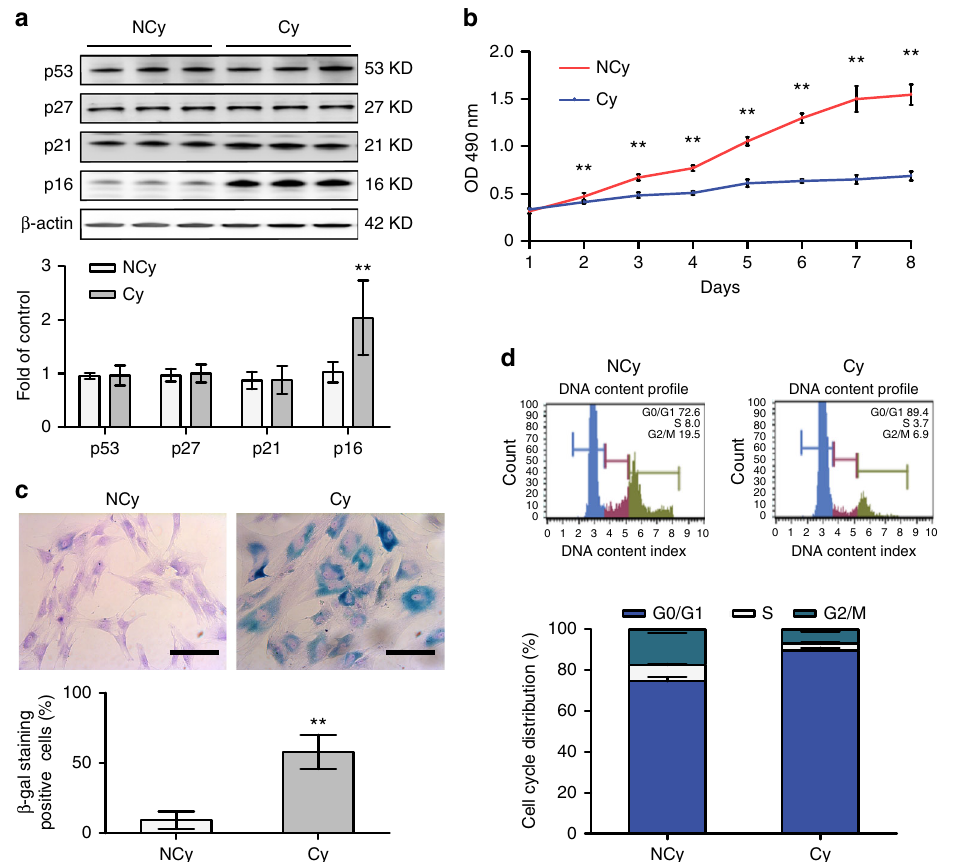
Fig. 1 BMSCs from CCHD patients are predisposed to premature senescence. a BMSCs from non-CCHD (NCy) and CCHD (Cy) patients ( n = 5 per group) were isolated and cultured to passage 3. Cell lysates were prepared to assess the levels of p53, p27, p21, p16 and β -actin by western blotting. b Cell numbers were determined by MTT assays at the indicated times. OD optical density. c SA- β -gal activity was assessed in the cells described in a . BMSCs stained in blue were labelled β -galactosidase-positive cells. Representative images are shown (upper). Scale bar, 50 μ m. Twenty fi elds of each section were randomly selected to calculate the ratio of β -galactosidase-positive cells. d Cells described in a were collected and subjected to FACS analysis to assess the cell cycle distribution (upper). The percentage of cells in each cell cycle compartment is presented graphically (lower). Data represent the mean ± SD from three independent experiments, and statistical signi fi cance was analysed using Student ’ s t -test (** P <